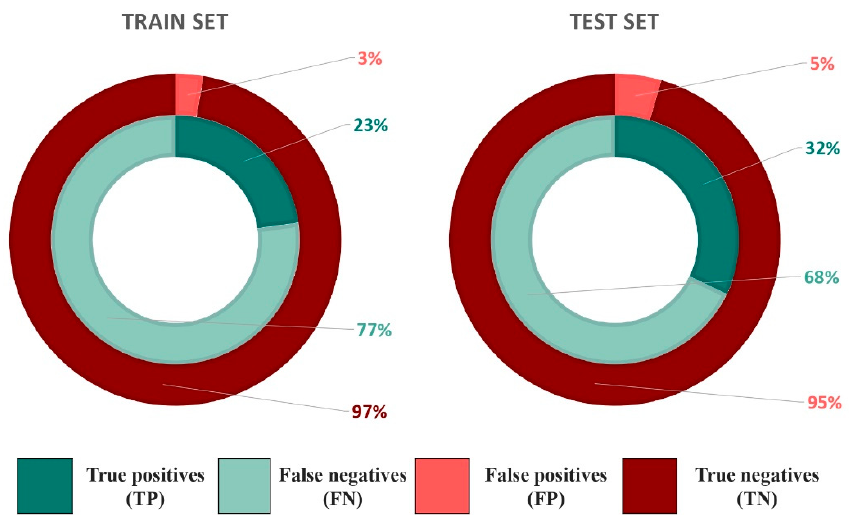
Figure 3. Pie charts displaying the performance of the combination of structure-based and ligand- based SBLB pharmacophores for the train and the test sets.